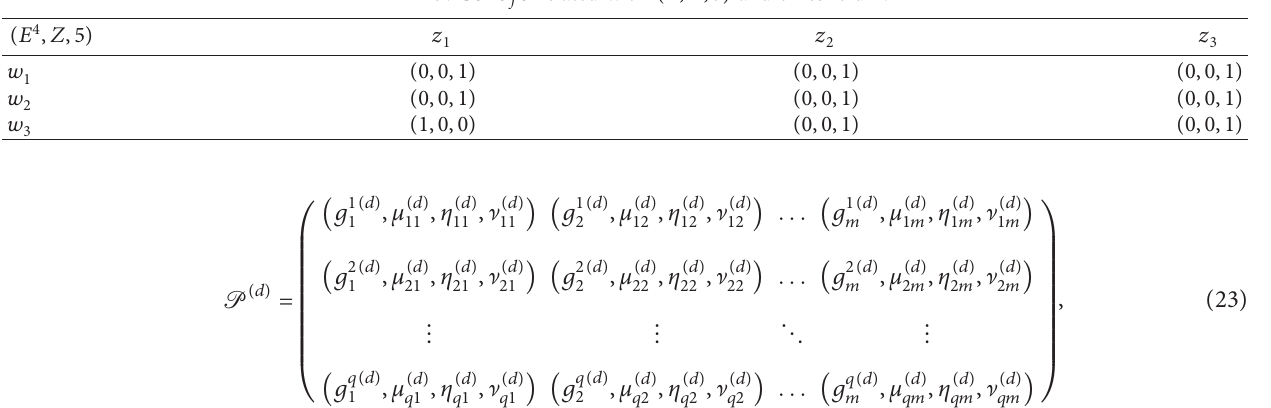
Table 19: CSFS S related with ( E, Z, 5 ) and threshold 4. f